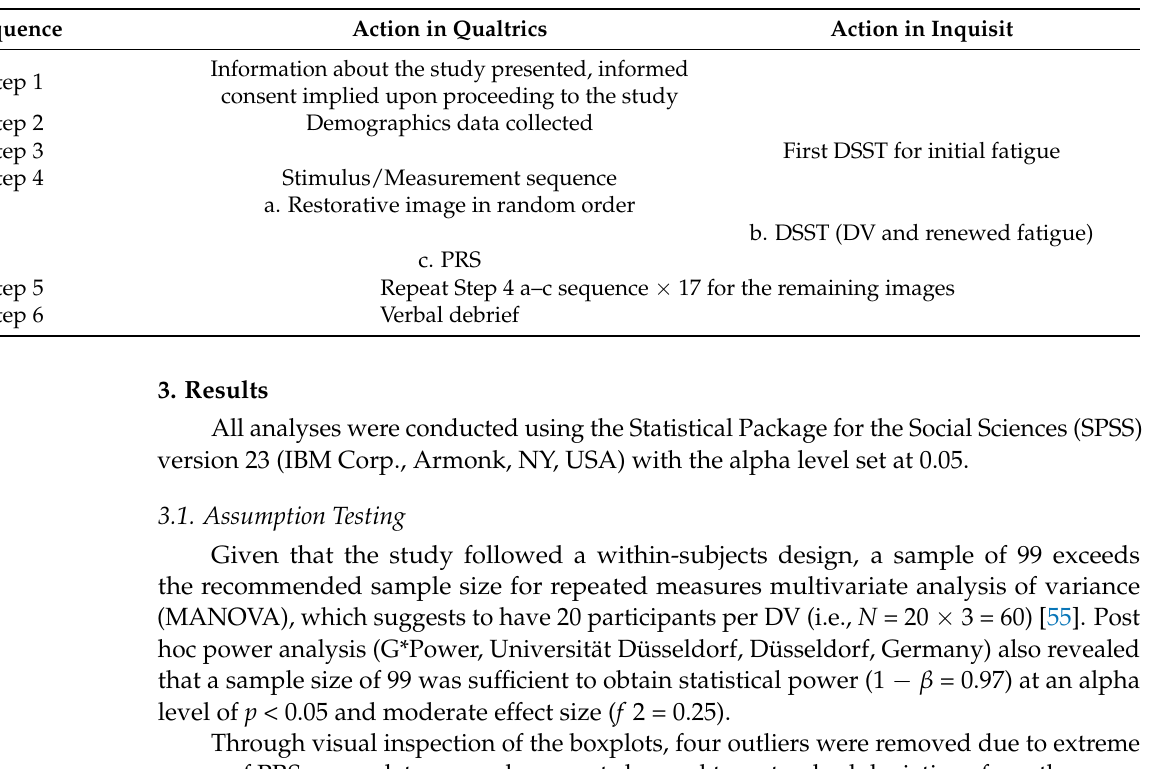
Table 1. Participation Sequence for the